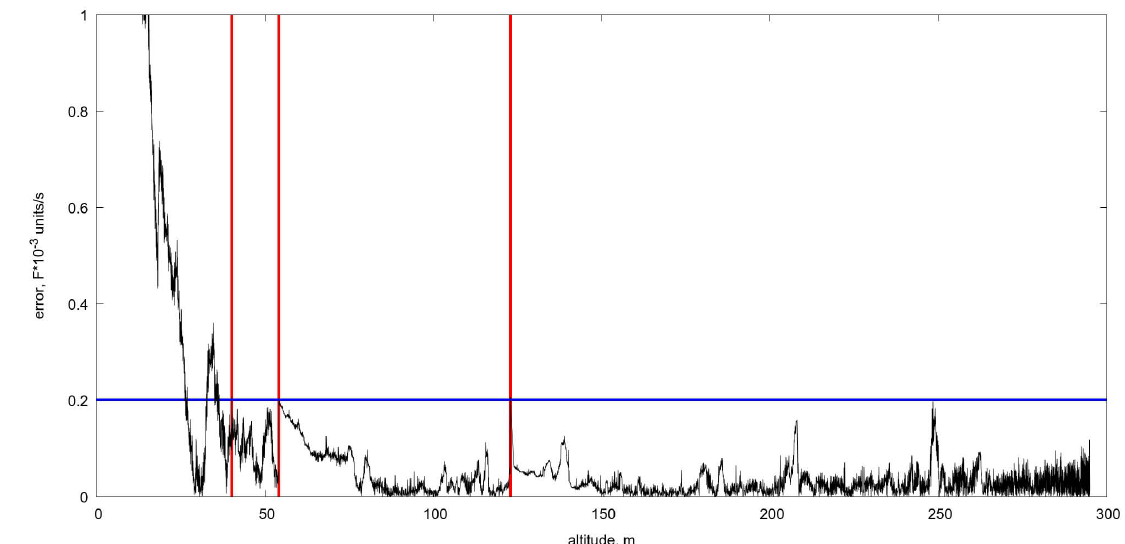
Figure 14. The difference (error) of the optical flow velocities via Lucas-Kanade and exact values, calculated at different altitudes from 300 m to 0 m. Vertical red lines show moments of switching of the averaging levels, that are: 4 × 4, 8 × 8, 16 × 16, and 30 × 30 from right to left.